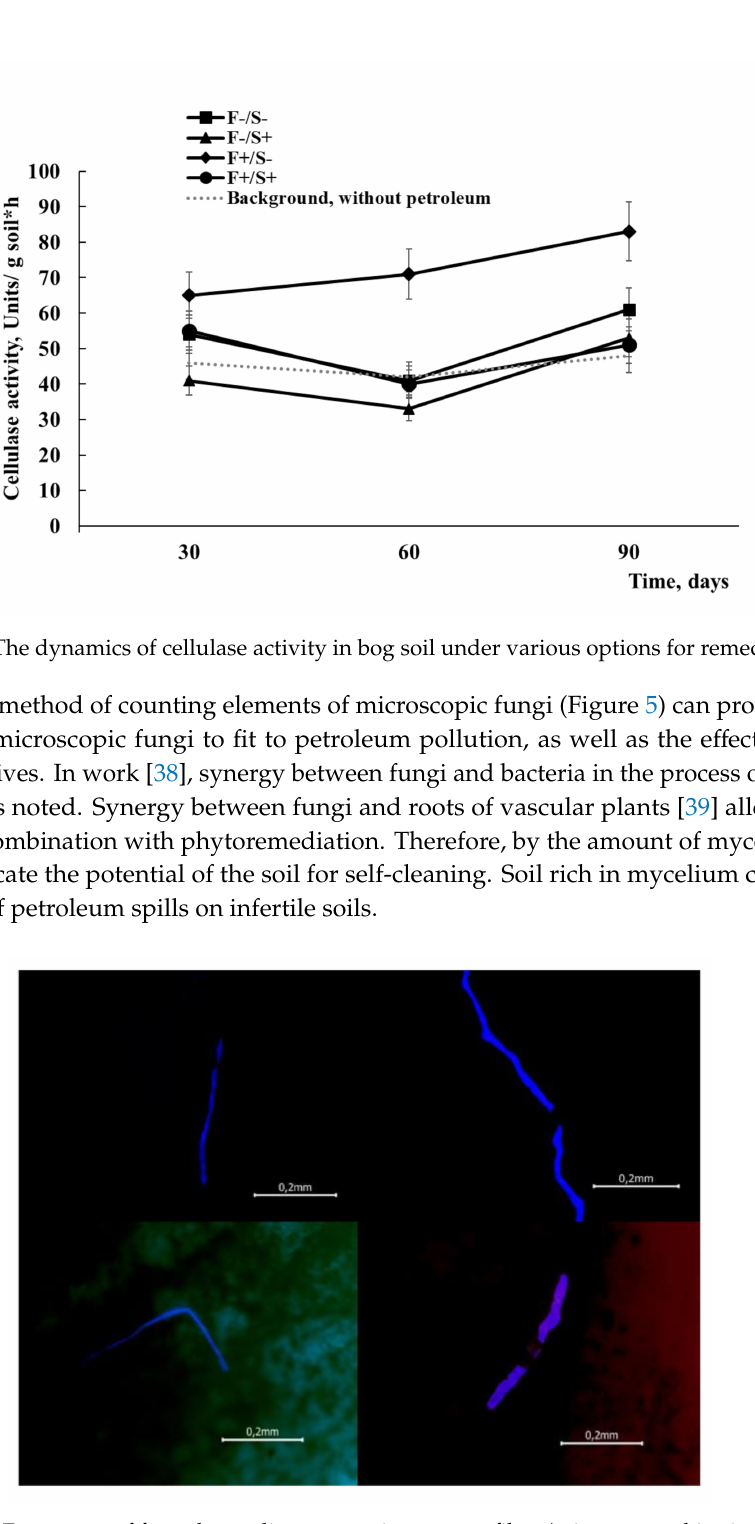
Figure 5. Fragments of fungal mycelium on a microporous filter (microscope objective 40 ×